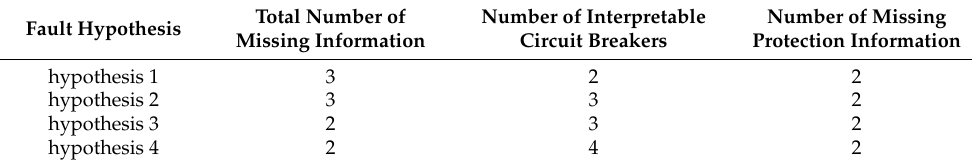
Table 1. Description of each dimension of fault hypothesis.